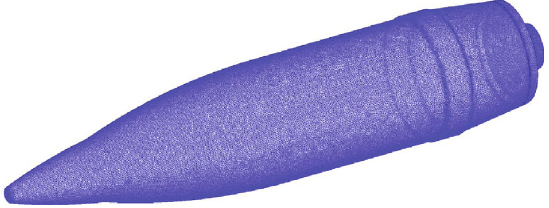
Figure 1: Computational model of the present